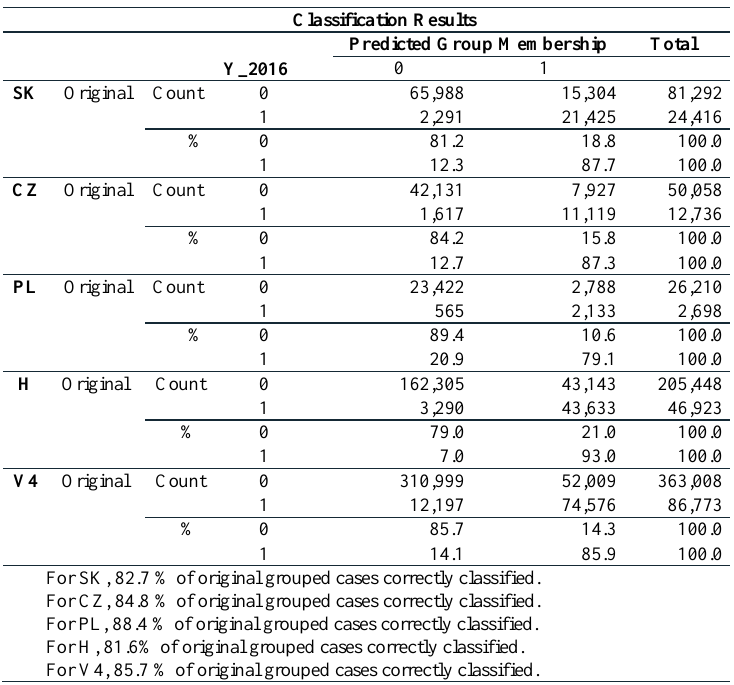
Table 6. Classification ability of V4 prediction